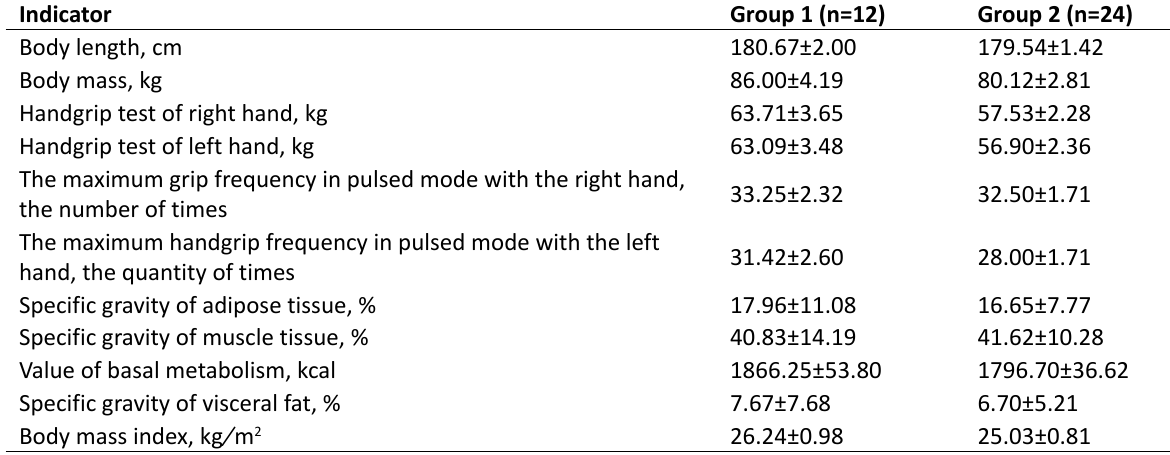
Table 1. Indicators of physical development and somatotype of arm wrestlers with different skill levels